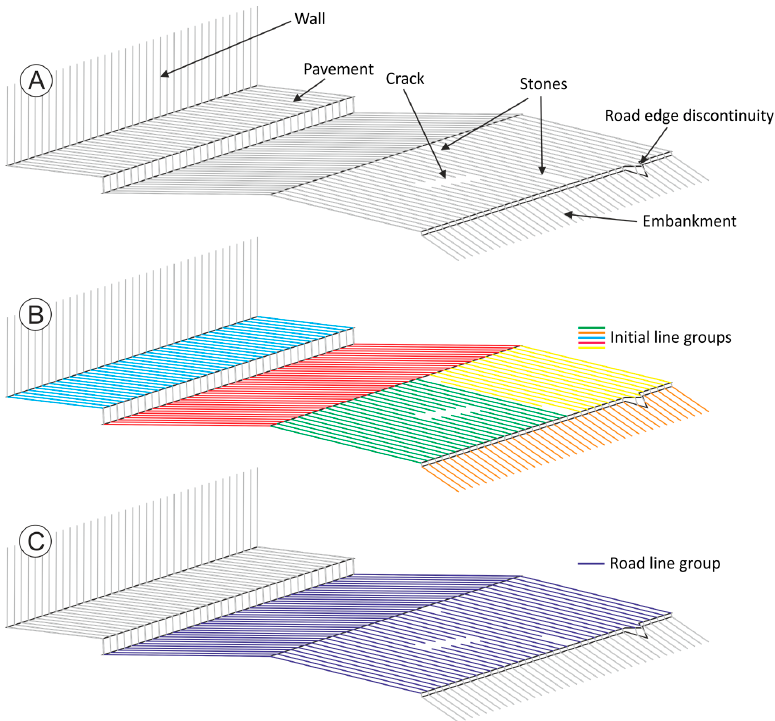
Figure 5. Line grouping on a road section. ( A ) Elements that produce disaggregation among the road surface groups; ( B ) Initial line groups; ( C ) Final group.